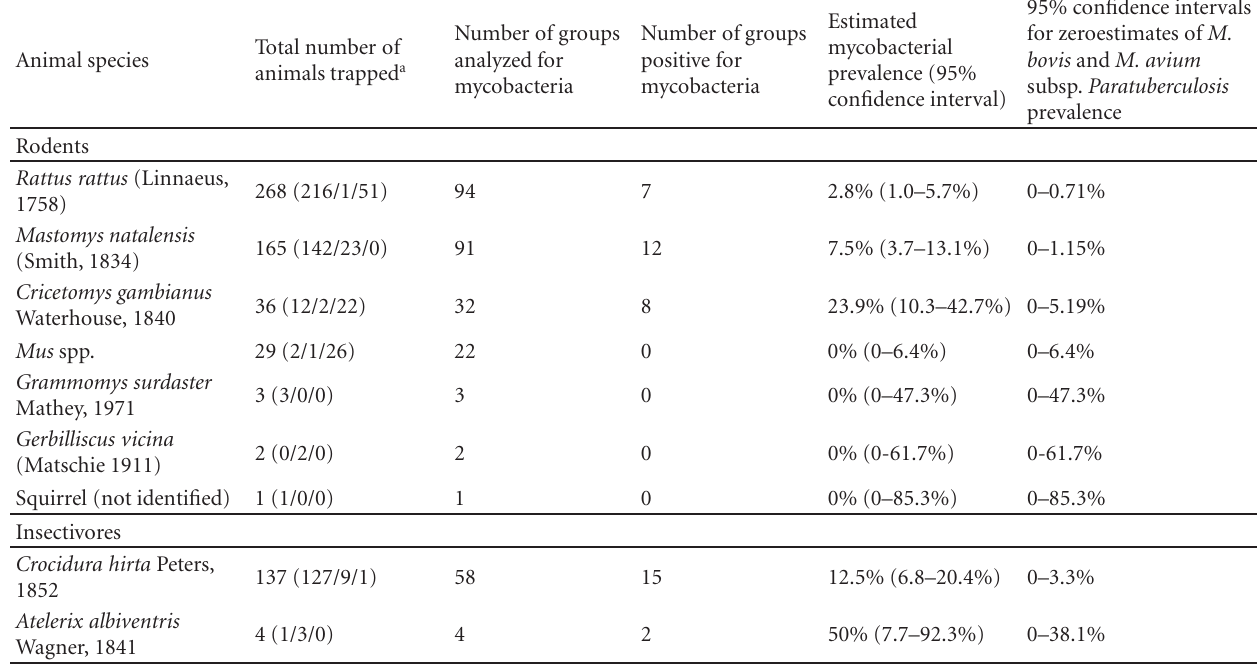
Table 2: Rodents and insectivores trapped in and around Morogoro and the prevalence of mycobacteria in the di ff erent animal species.